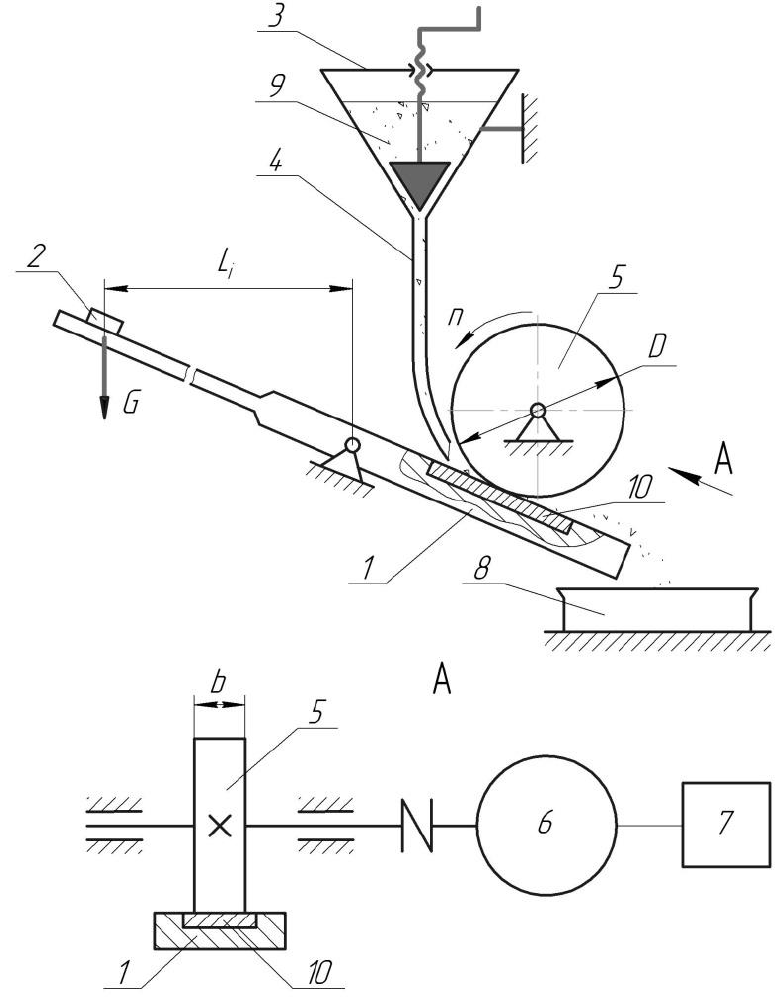
Figure 3. Scheme of the dry sand and rubber wheel abrasion testing machine: 1—sample-fixing lever, 2—removable weight, 3—abrasive hopper, 4—nozzle for supplying of an abrasive particles into the friction zone, 5—rubber wheel, 6—electric motor, 7—device for regulating the speed of the engine, 8 — container for used abrasive, 9 — abrasive particles, 10 — flat sample with hardfacing layer.